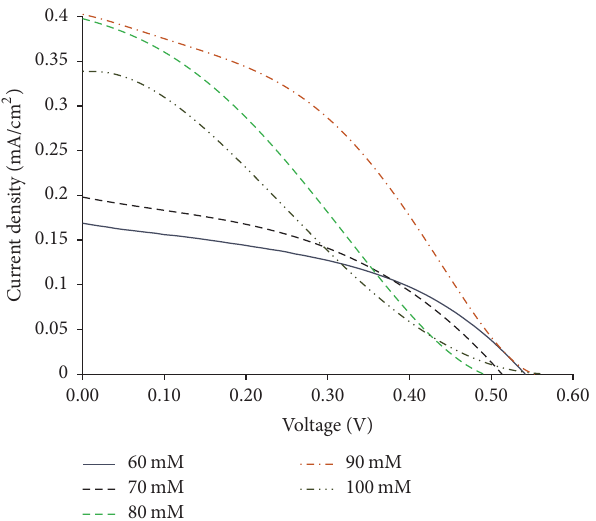
Figure 4: 𝐼 - 𝑉 curves of DSSCs under irradiation intensity of 100mW/cm 2 .